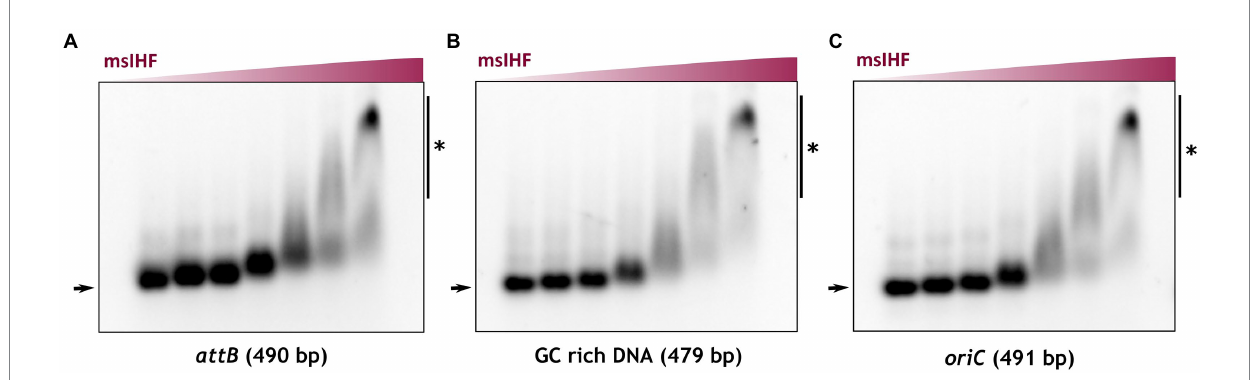
FIGURE 6 Analysis of msIHF DNA binding in vitro . Electrophoretic mobility shift assay (EMSA) results. Linear DNA fragments including the attB site (A) (positive control), oriC (B) , and GC-rich DNA (C) (negative control) were incubated with increasing concentrations of recombinant msIHF (0, 0.08, 0.16, 0.35, 0.7, 1.4, and 2.8 μ M) and a nonspecific competitor (poly dI-dC). Nucleoprotein complexes created by the binding of msIHF with the analyzed DNA fragments are marked with vertical lines and a black